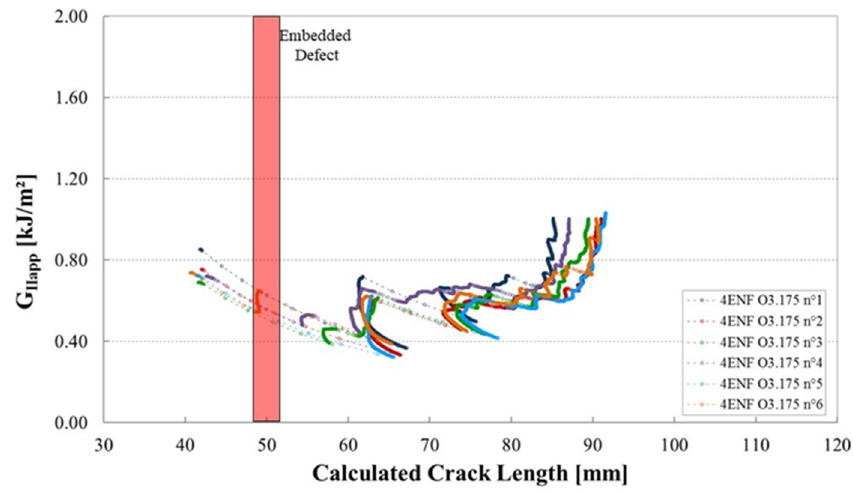
Figure 15. Mode II fracture energy as a function of the crack length for six 4 ENF specimens con- taining a gap of 6.35 mm from plates manufactured with caul plate.